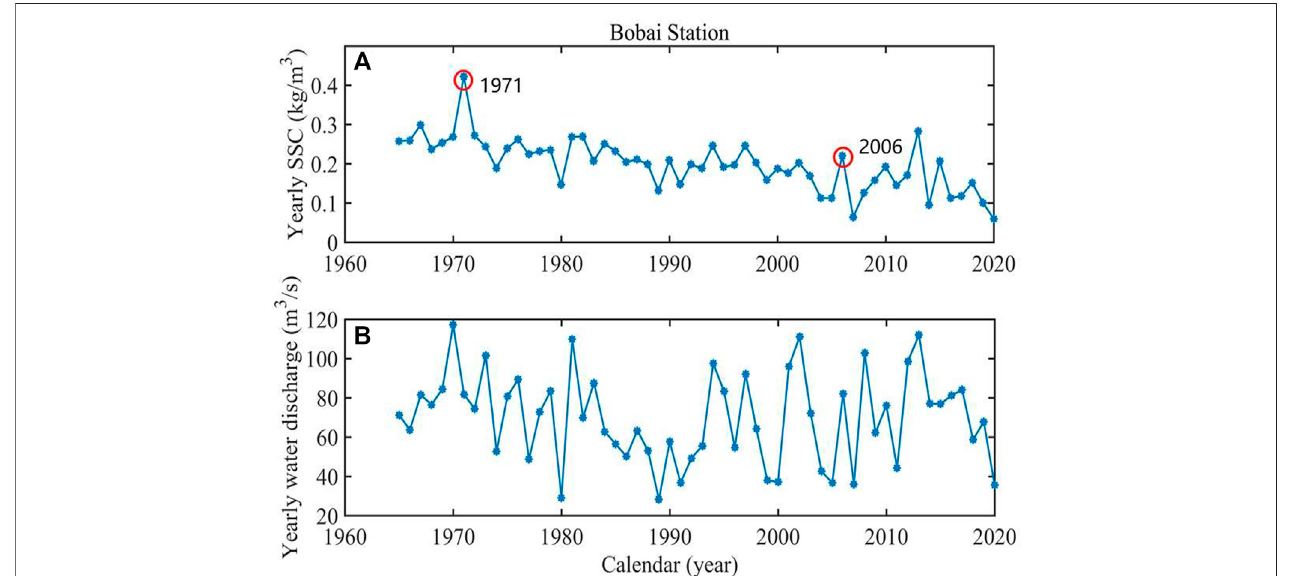
FIGURE 2 | Variation trends of the yearly SSC and yearly water discharge at the Bobai Station from 1965 to 2020 (A) variation in the average SSC; (B) variation in the water discharge.